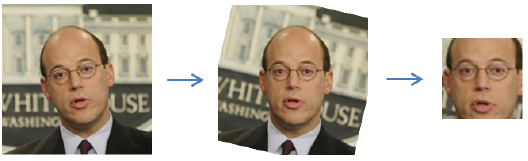
Figure 11: Face normalization